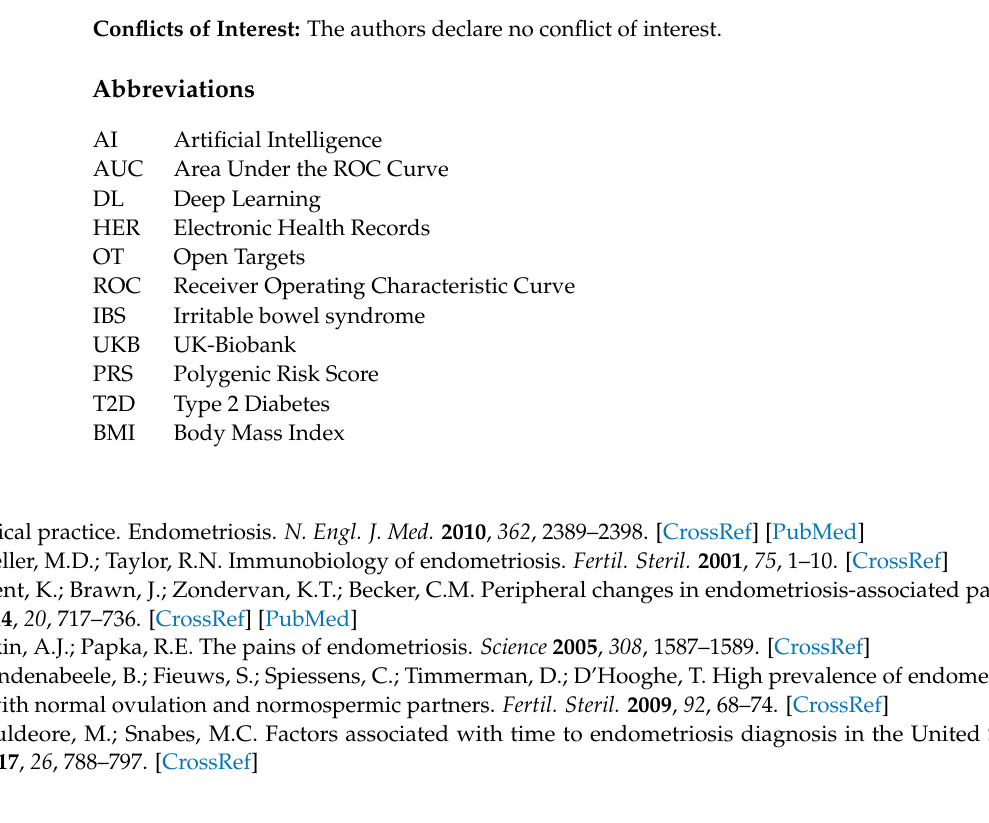
S5: Performance of predictive models for endometriosis using CatBoost [Source for Figure 5]. Table S6: Comparing machine learning algorithms for combined models (10 iterations each) [Source for Figure 5C]. Table S7: Informative features from the combined model, ranked by SHAP for Caucasians and mixed ethnicity